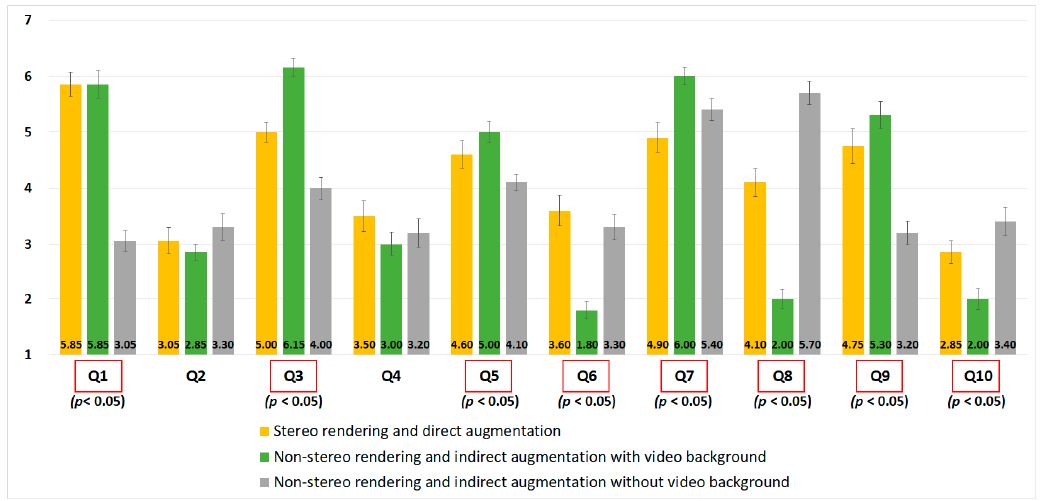
Figure 16. Qualitative result for visual contexts.